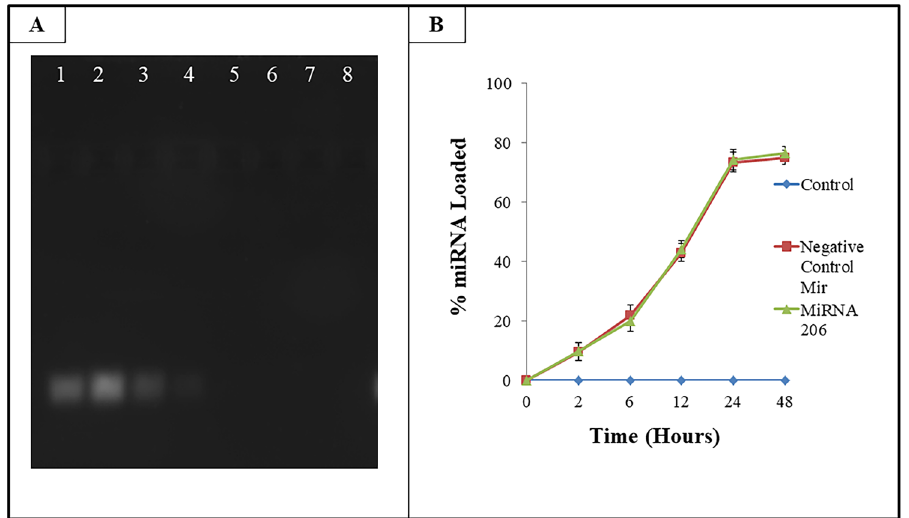
Figure 2. Percent loading efficiency of gold nanoparticles ( A ) Agarose gel electrophoresis of PEG Capped AuNPs incubated with miRNA at various time points. (1) 50 nM miRNA (2)100 nM miRNA (3) AuNPS + miRNA (2 h) (4) AuNPS + miRNA (4 h) (5) AuNPs + miRNA (6 h) (6) AuNPS + miRNA (12 h) (7) AuNPs + miRNA (24 h) (8) AuNPs + miRNA (48 h) (full-length gel image has been included in a